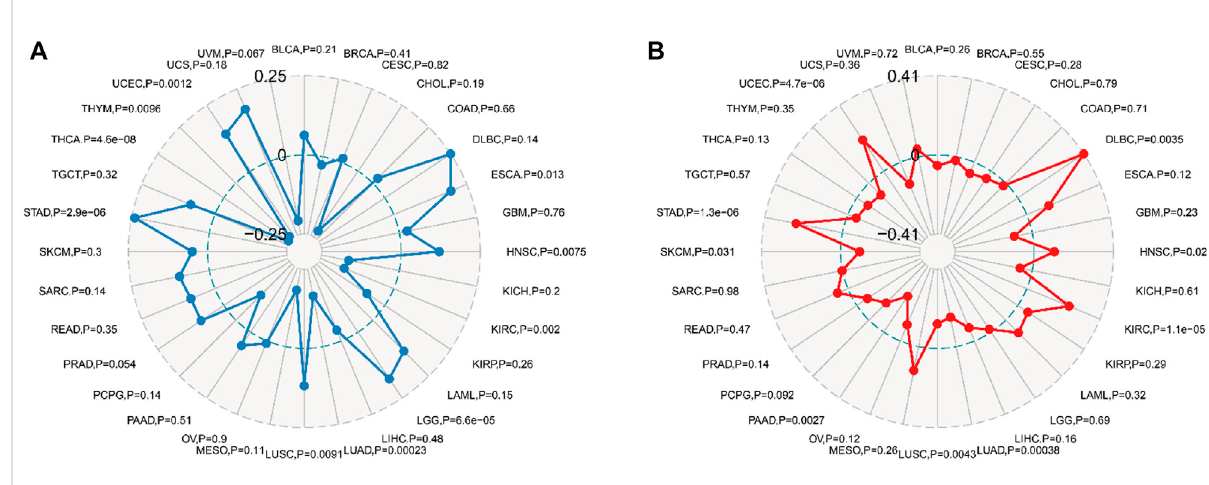
FIGURE 9 Relationship between tumor mutational burden (TMB), microsatellite instability (MSI), and FDX1 mRNA expression levels in different tumors in theCancerGenomeAtlasdatabase.TMBwascalculatedbythetotalmutationincidencepermillionbasepairsineachtumor,andMSIwascalculated by the total incidence of deletions or insertions per million base pairs of repeats. (A) correlation between TMB and FDX1 expression. (B) correlation between MSI and FDX1 expression. Spearman correlation test, p < 0.05 was evident.